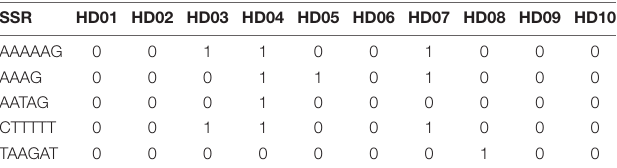
Genes drawn outside of the circle are transcribed counterclockwise, while genes shown inside of the circle are transcribed clockwise. Genes belonging to different functional groups are color-coded. Darker gray in the inner circle indicates GC content, while lighter gray corresponds to AT